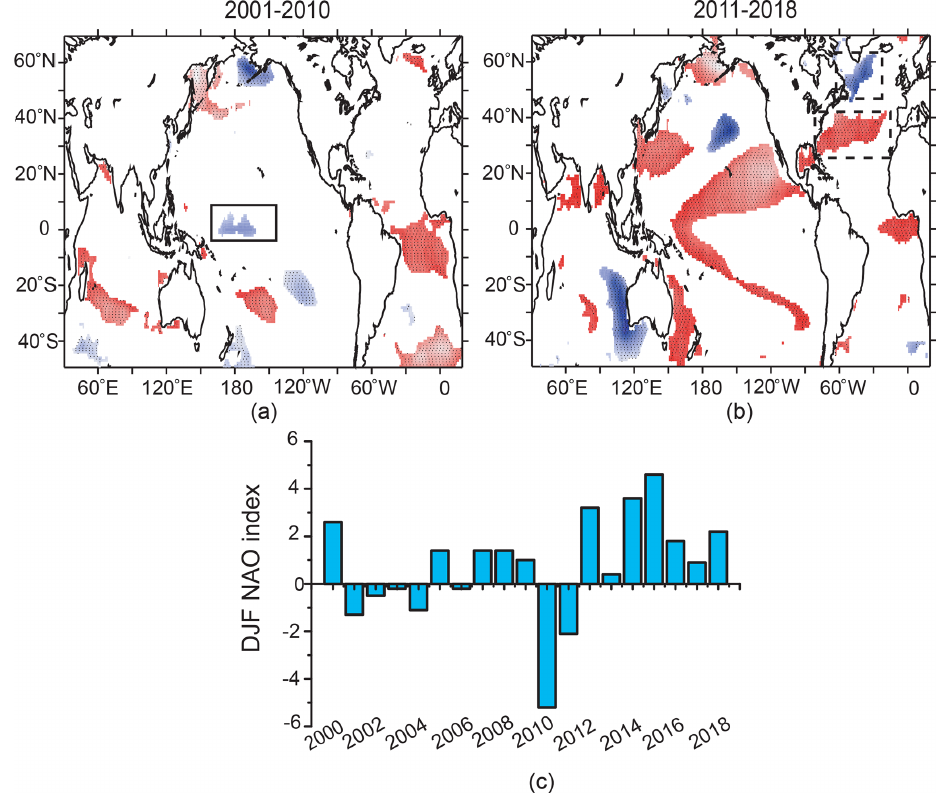
Figure 5. Regions experiencing positive (red shading) and negative (blue shading) trends in sea surface temperature during (a) September– October of 2001–2010 and (b) April–June of 2011–2018 that are significant at the 90% confidence level. The overlaid black stippling shows the regions where the trend is significant at the 95% confidence level. (c) Time series of the December–February Hurrell’s station-based NAO index for